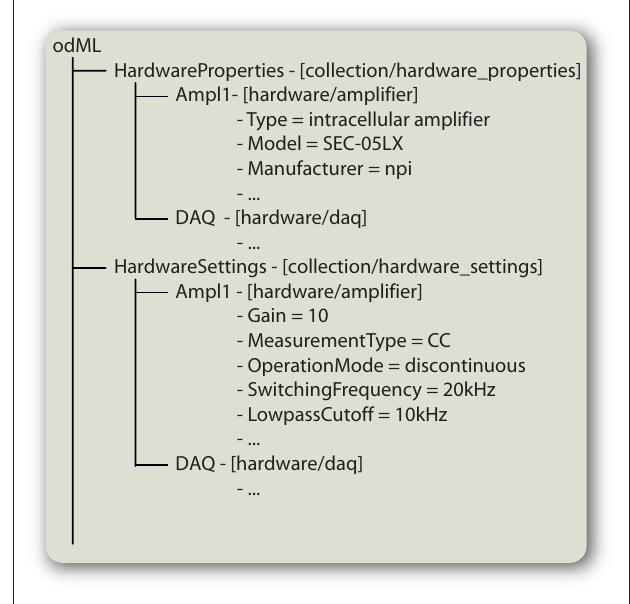
Figure 3 | Hardware descriptions in od ML. Hardware descriptions can be split up into the HardwareProperties and HardwareSettings . These container sections then group subsections for the individual hardware items used in the setup. Sections are shown in the form “name –